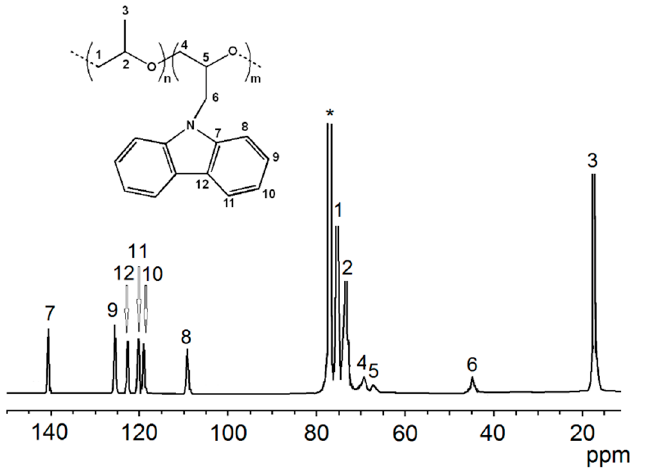
Figure 3. 13 C NMR spectrum of PPO- b -PEPK copolymer sample 2 (Solvent: CDCl 3 (*), TMS. scale, 25 °C). In Table 2, carbon numbers are referred to those in the figure.